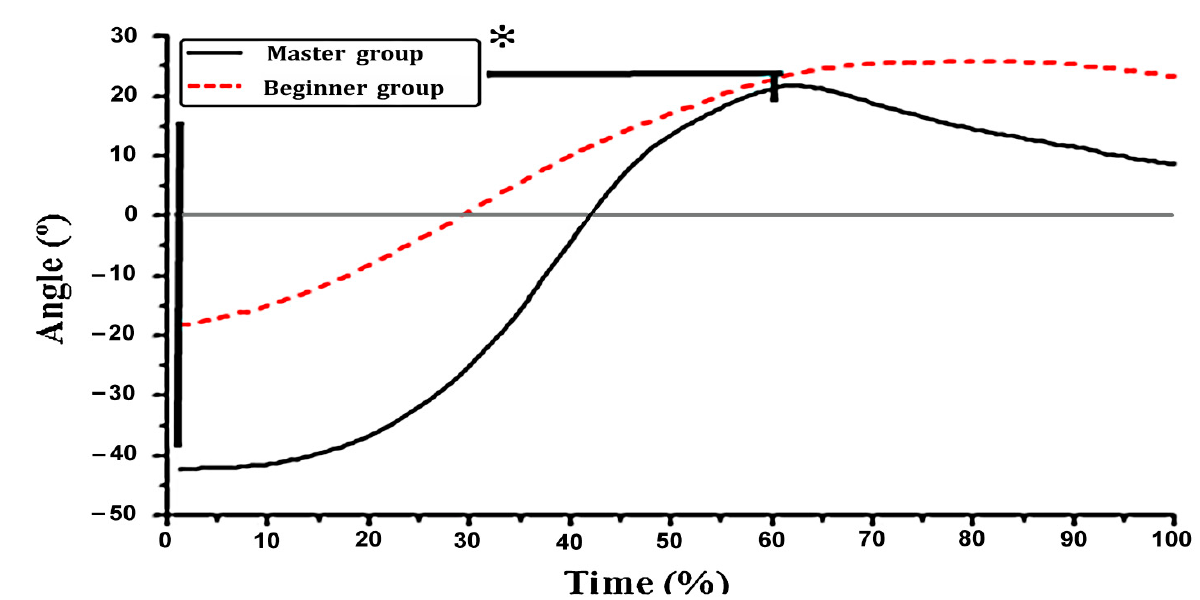
Figure 8. Change in the hip joint rotation angle. * indicates p < 0.05, ** indicates p < 0.01.